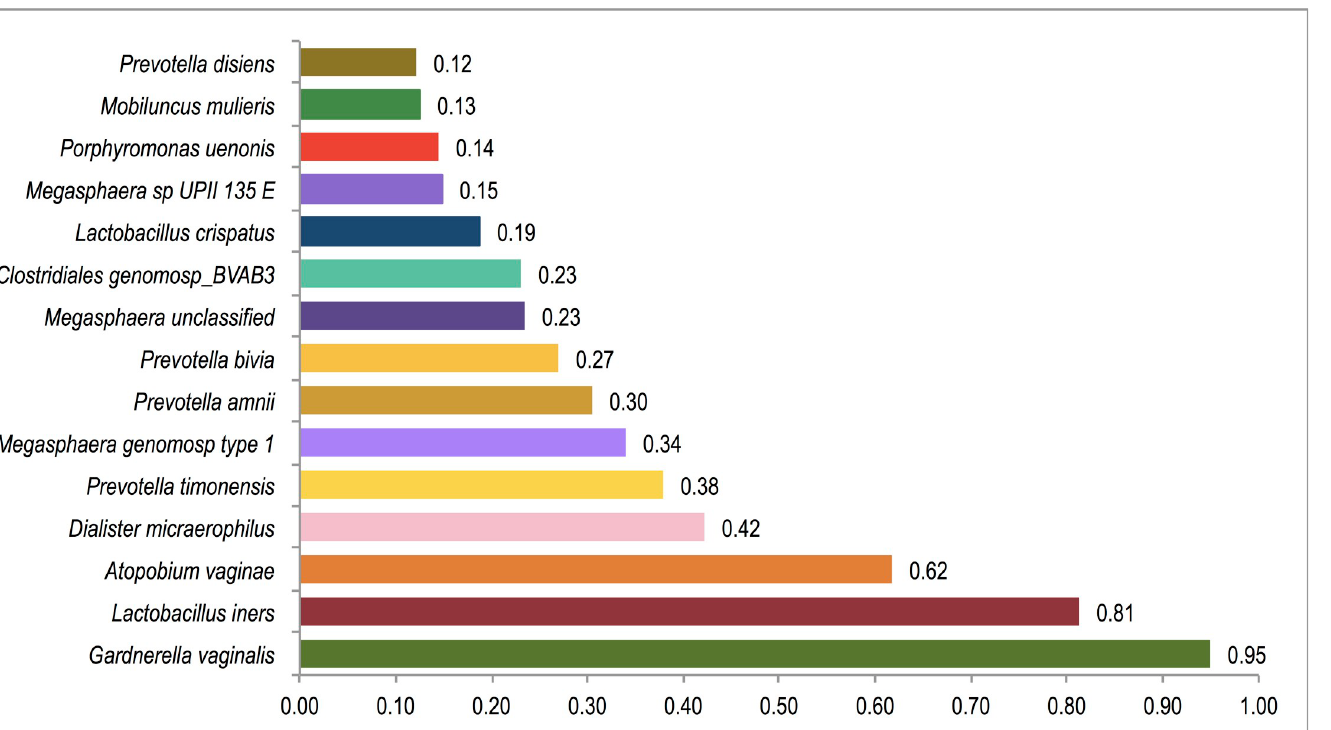
tus (CST 1; n = 34/256, 17% weighted), L . iners (CST 3; n = 77/256, 32% weighted), G . vaginalis (CST 4-I; n = 97/256, 37% weighted), G . vaginalis & A . vaginae (CST 4-II, n = 18/256, 5% weighted), and mixed anaerobes (CST 4-III, n = 25/256, 9% weighted) (Fig 3). There was sub- stantial prevalence of G . vaginalis in samples within the L . iners -dominant CST 3: the mean rel- ative abundance of L . iners across specimens clustered in CST 3 was 0.81 (SD ± 0.19); the second most common species was G . vaginalis (0.11 ± 0.14).